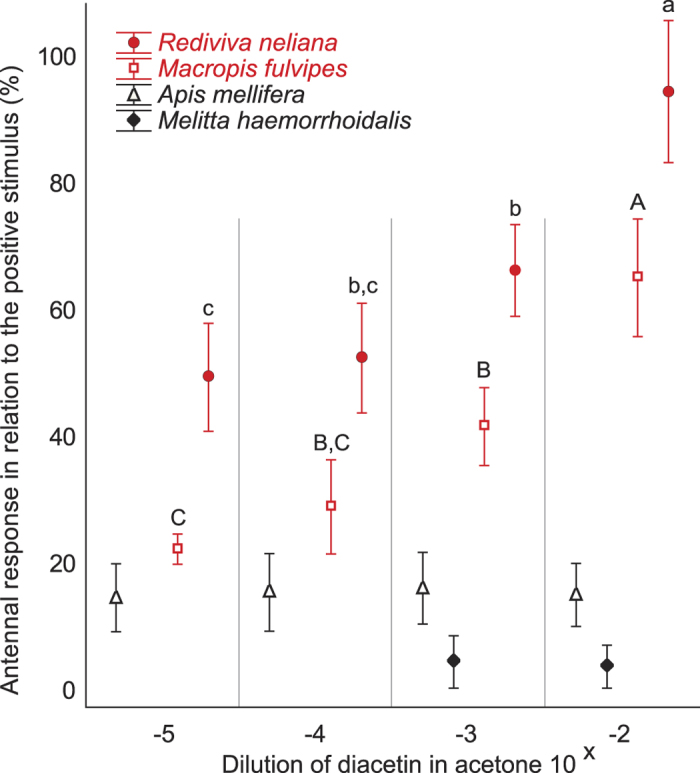
Physiological dose-response curves of different bees for diacetin.Electroantennographic responses (EAG) of oil bees (Macropis fulvipes/Rediviva neliana) and non-oil bees (Melitta haemorrhoidalis/Apis mellifera) to different dilutions of diacetin. SEM = standard error of the mean. Means (within the same species) that share same letters or do not have letters are not significantly different.